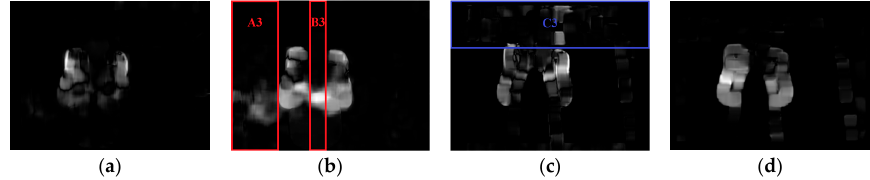
Figure 2. Grayscale and depth optical flow corresponding to Figure 1. ( a ) Grayscale horizontal velocity V t , r ; ( b ) Grayscale vertical velocity V t , c G velocity V t , c D